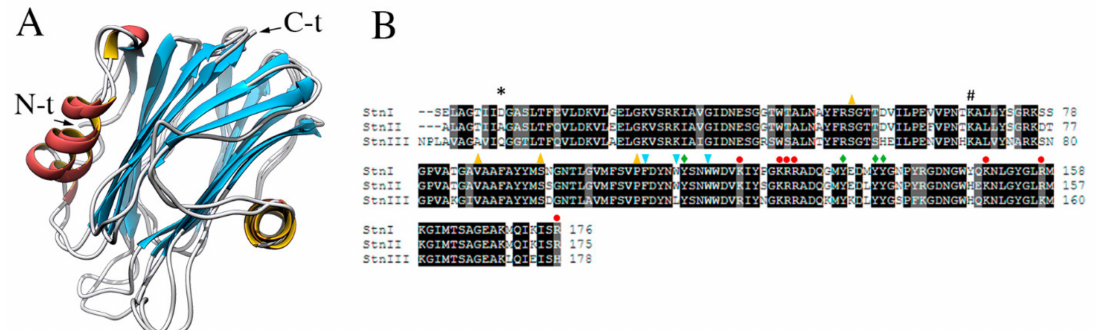
Figure 6. ( A ) Three-dimensional structures of StnI (2KS4) and II (1GWY). ( B ) Sequence alignment of StnI, II, and III. Identical residues are highlighted in black, those with similar / conserved chemical properties appear grey, and nonconserved residues remain backgrounded in white. Black asterisk (*) indicates StnI Asp9 (Ala8 and Gln11 in StnII and StnIII, respectively). Black hashtag (#) indicates a conserved Lys residue in StnI, StnII, and StnIII, occupying positions 68, 67, and 70, respectively. As indicated in Figure 5, red circles highlight residues that conform the array of basic amino acids. Light blue arrowheads pointing down indicate the residues taking part of the cluster of aromatic residues, yellow arrowheads pointing up mark the amino acids that are part of the POC binding site, and green diamonds indicate residues belonging to both the cluster of aromatic residues and the POC binding site. These residues appear conserved in all three Stns except for those corresponding to StnI Trp111, Lys119, and Arg176 which, only in StnIII, are Leu113, Arg121, and His178. This figure has been modified from